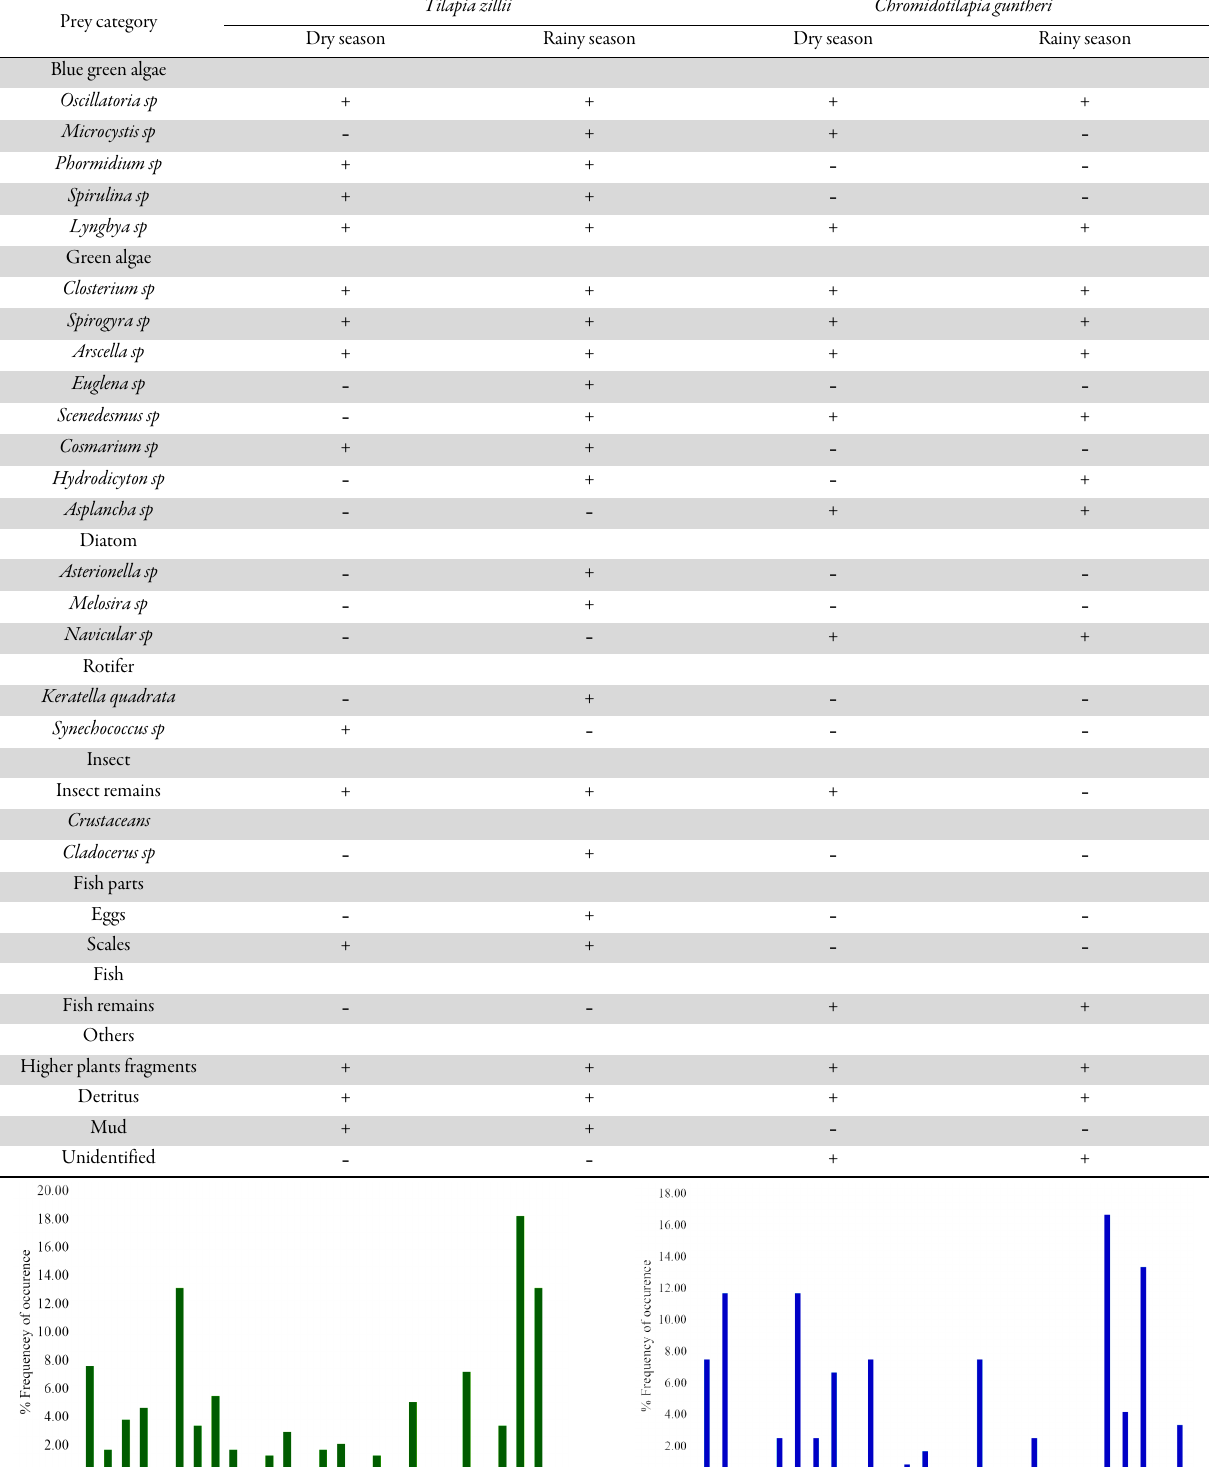
Table 3. Seasonal variations in the diets of Tilapia zillii and Chromidotilapia guntheri from Igun gold mine reservoir Prey category